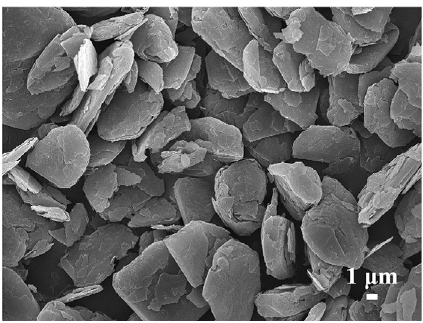
Fig. 1 Micromorphology of spherical graphite raw material.